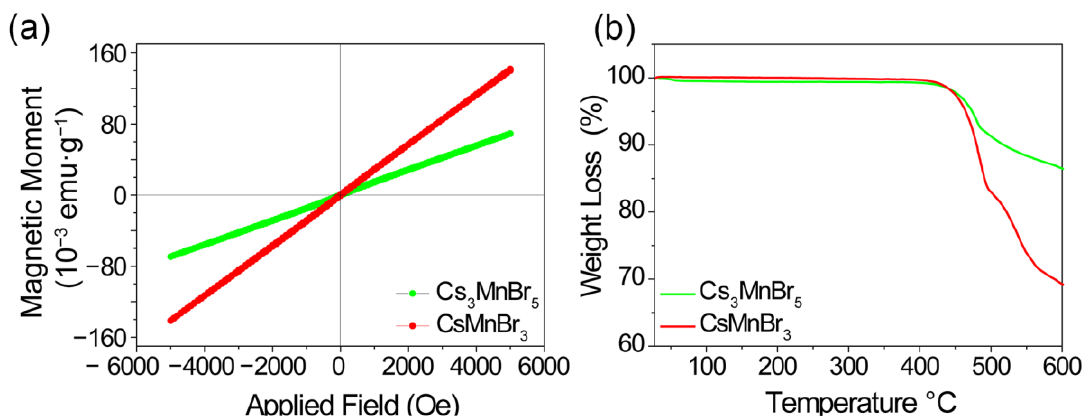
Figure 6. ( a ) Magnetic properties of Cs 3 MnBr 5 and CsMnBr 3 at room temperature. ( b ) Thermogravimetric (TGA) curves of Cs 3 MnBr 5 and CsMnBr 3 in air atmosphere at a heating rate of 10 °C/min.